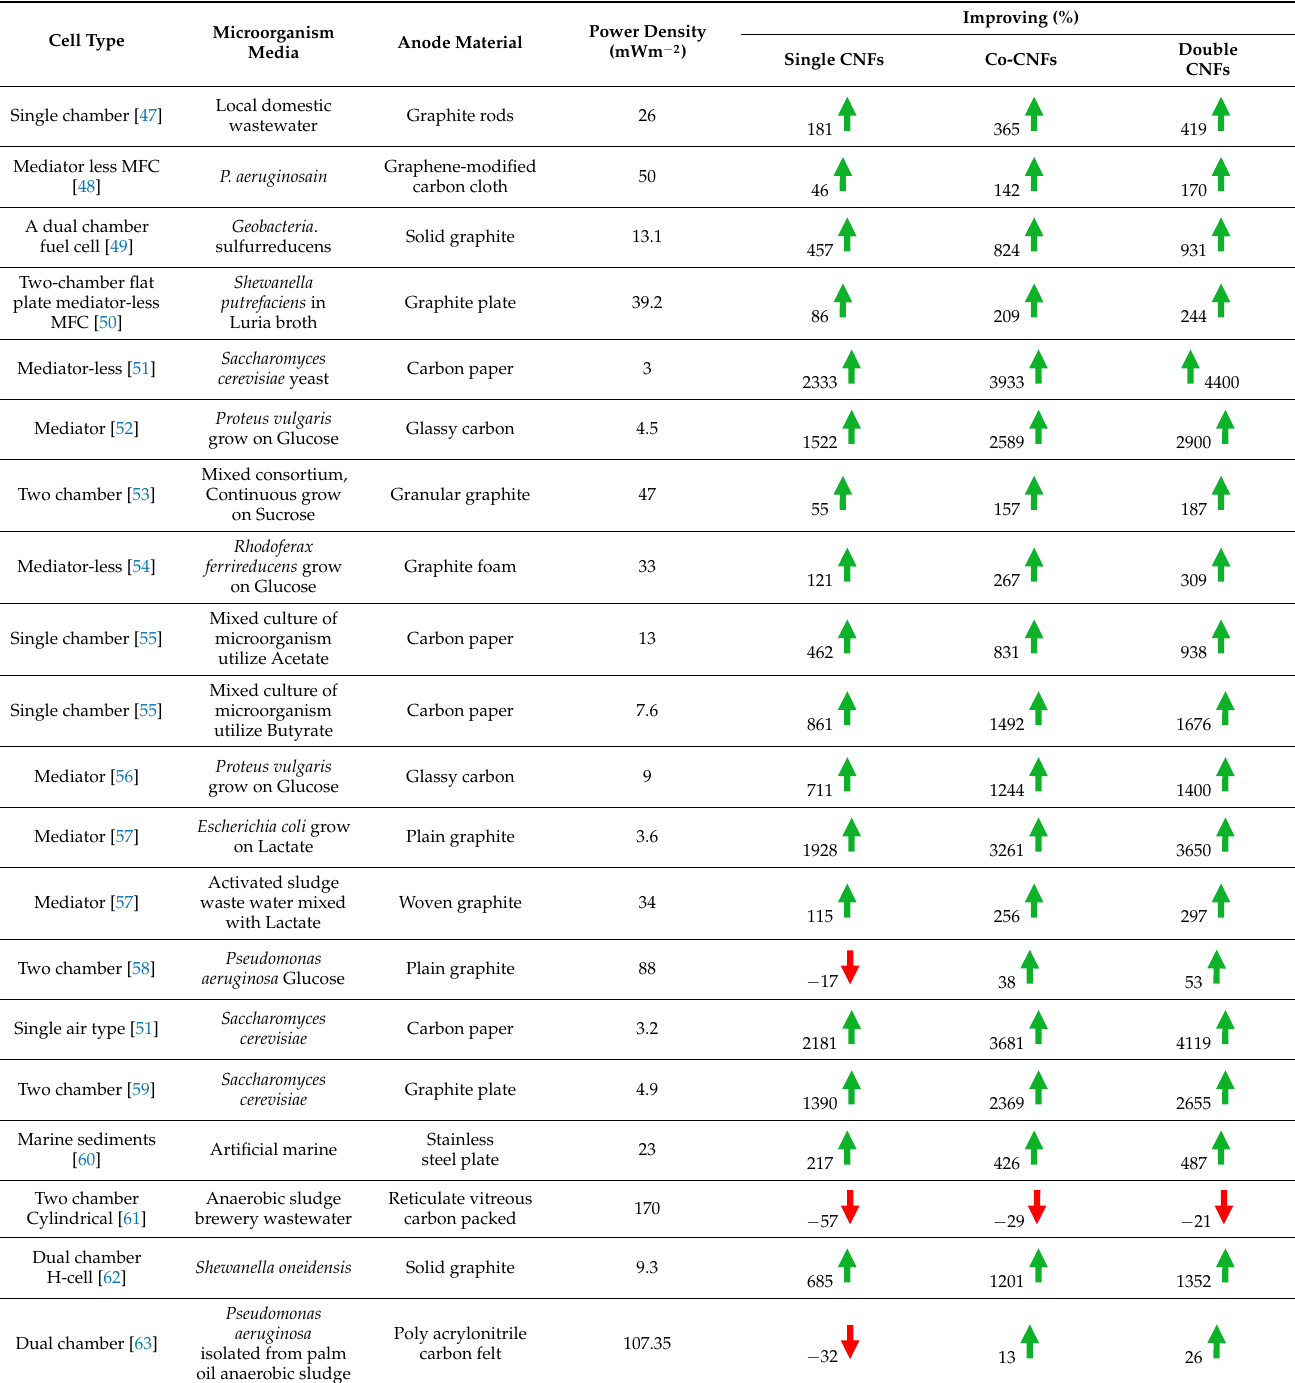
Table 1. Performance of the reported MFC anodes in the literature in terms of power density gen- eration compared with the proposed anodes in this study.